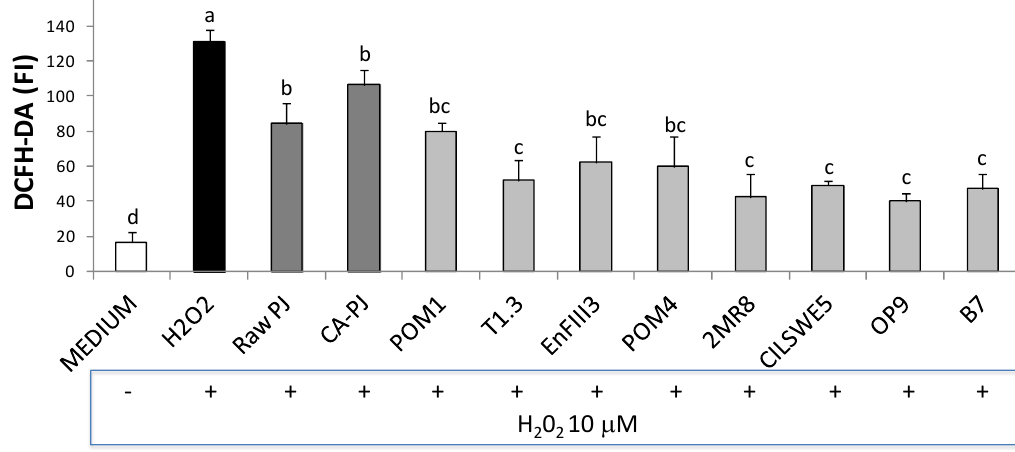
Figure 4. Intracellular reactive oxygen species (ROS) level in Caco-2 cells, measured as the fluorescence intensity (FI) of 20,70-dichlorofluorescin diacetate (DCFH-DA). Caco-2 cells were pretreated for 18 h with raw Portulaca oleracea L. juice (Raw-PJ), chemically acidified PJ (CA-PJ), and PJs fermented (30 °C for 36 h) by Lactobacillus plantarum POM1, T1.3, and EnFIII3, Lactobacillus brevis POM4, Lactobacillus rossiae 2MR8, Pediococcus pentosaceus CILSWE5, Leuconostoc mesenteroides OP9, and Lactobacillus kunkeei B7. Two hours before the end of the treatment, Caco-2 cells were treated with 10 µM H 2 O 2 to induce oxidative stress. Bars with different superscript letters differ significantly ( p < 0.05).